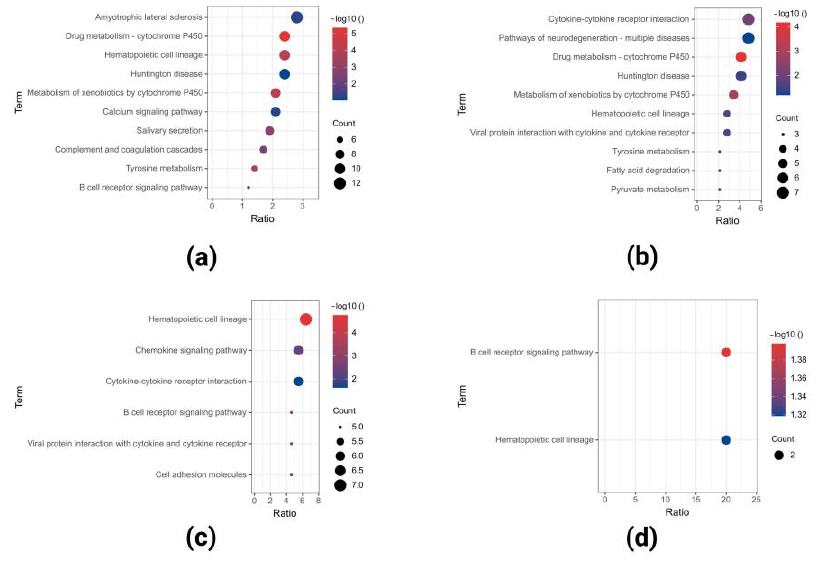
Figure 7. KEGG analyses of downregulated DEGs in GSE40290 ( a ), GSE61218 ( b ), GSE53819 ( c ), and co-downregulated DEGs ( d ) in the three datasets.